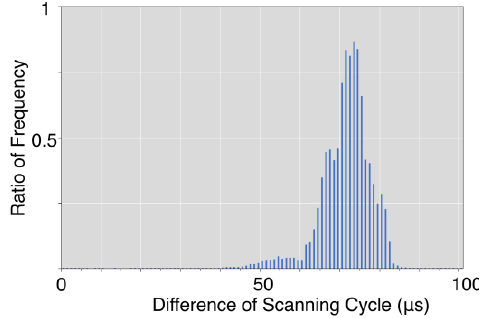
Figure 6. Deviation of rotational frequency of laser scanners On the other hand, in the trajectory-based point-cloud image, points are regularly arranged even if the rotation frequency deviates, because point clouds are adjusted using the MMS trajectories. In our method, point clouds can be mapped on an image in two modes. In the first mode, point clouds are mapped so that the trajectories coincide with the vertical center line of the image as shown in Figure 5(a). This mode is suitable for displaying roadways and objects on the road without separating them. In the other mode, point clouds are mapped so that the trajectories coincide with the vertical lines at the left and right edges of the image as shown in Figure 5(b). This mode is suitable for displaying objects located in high positions along a road, such as buildings, poles, trees, and